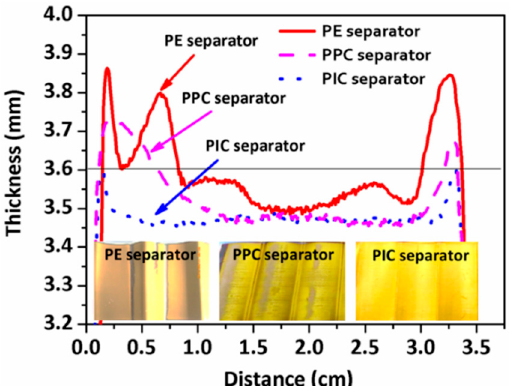
Figure 6. The thickness of the middle part of pouch cells with different separators from left to the right after 600th cycle. The inset shows the photographic image of the anode surface of pouch cells after 600th cycling test without any treatment.